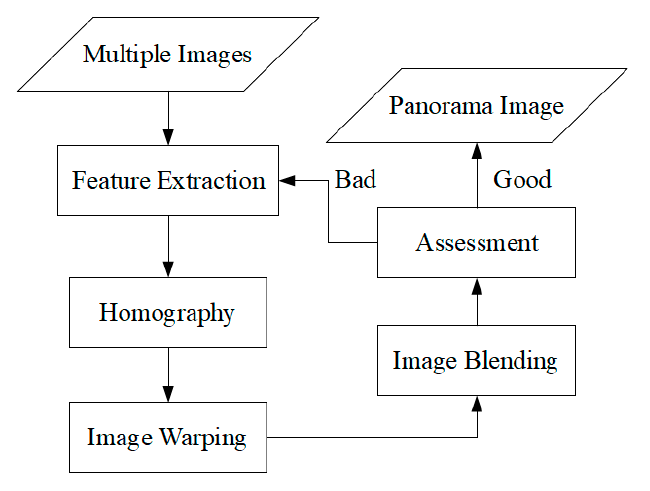
Figure 3. Procedure for image stitching.